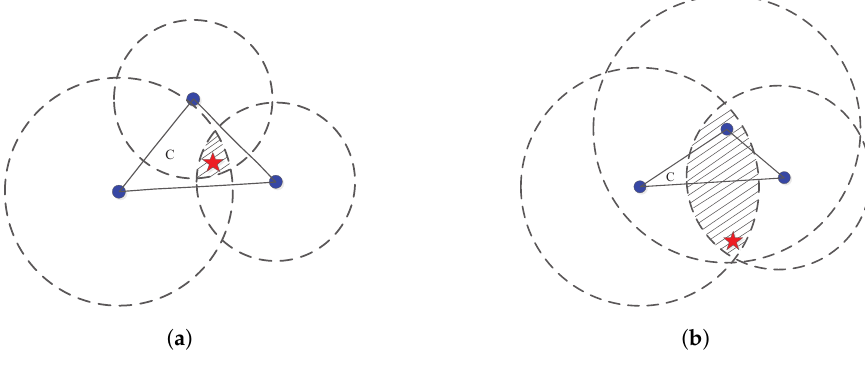
Figure 3. Illustration of the convex hull effect of one of the proposed alternative SOCP localization methods. The pentagram denotes the source and the solid circle denotes the sensor. ( a ) the source is located inside the convex hull (region C ) formed by N = 3 sensors; ( b ) the source is located inside the convex hull (region C ) formed by N = 3